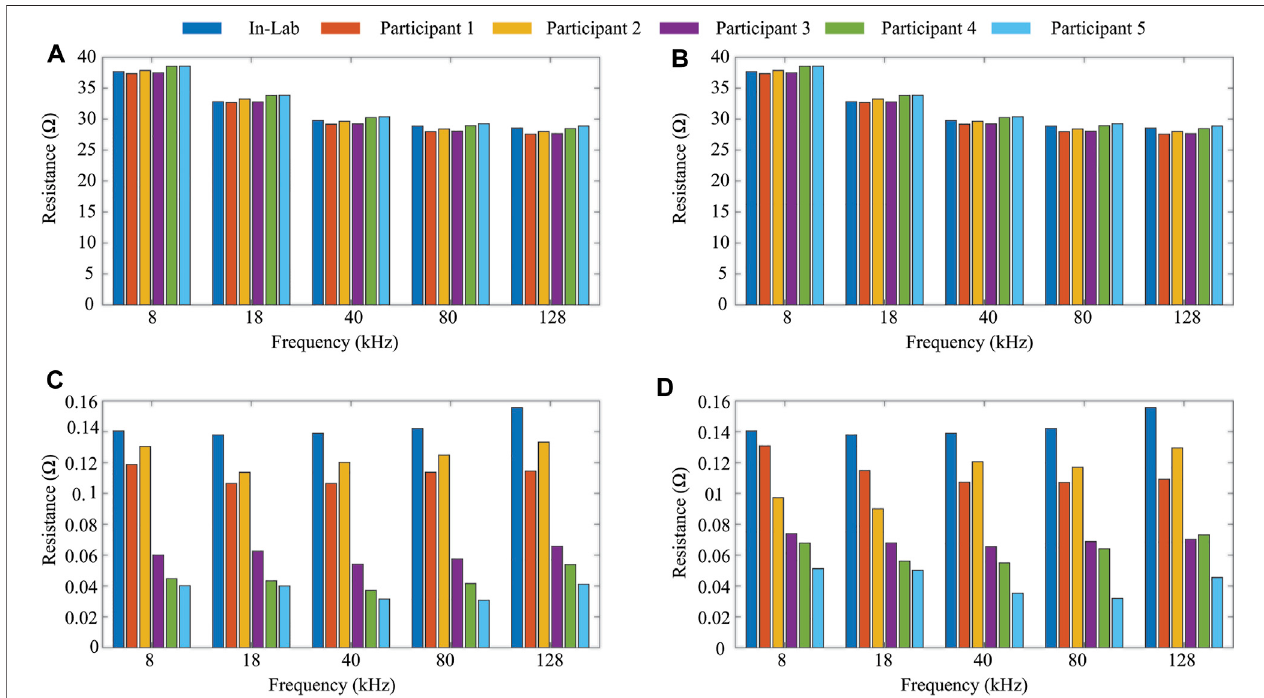
FIGURE 5 | Average (A,B) and standard deviation (C,D) resistance (8 – 128 kHz) of on-board 2 R -1 C model for days 1 and 2 of data collection from study participants.